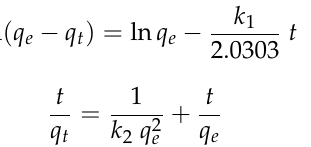
Figure 12. The Cr(VI) adsorption kinetics fitted by the pseudo-first-order ( a ) and pseudo-second- order ( b ) models.